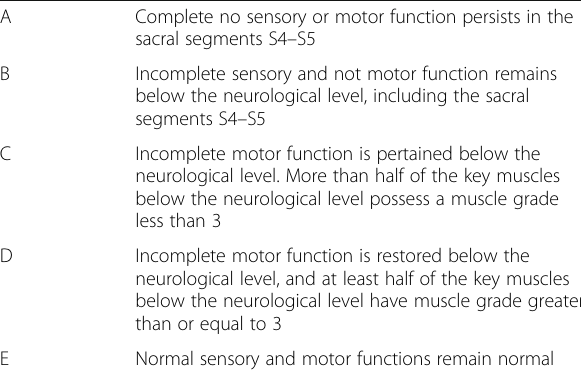
Table 1 The American Spinal Injury Association